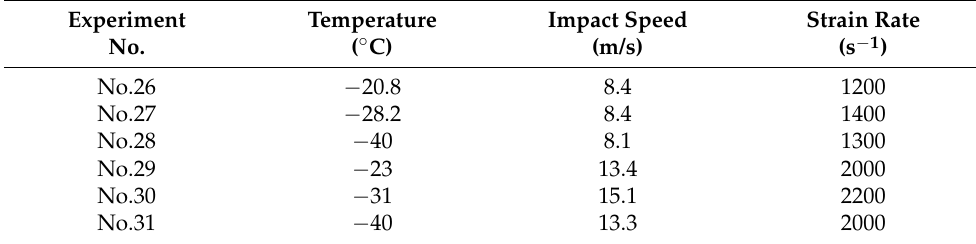
Table 2. Experimental parameters under different temperature.